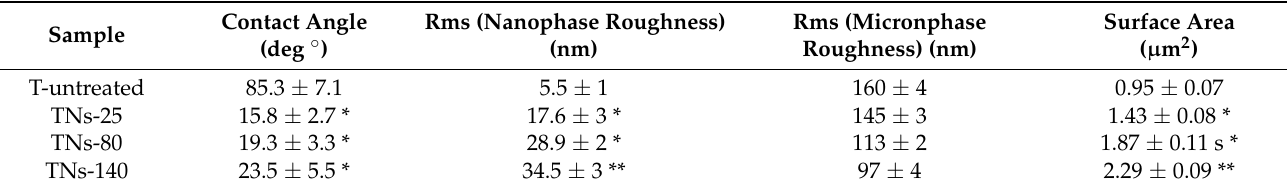
Table 3. Water contact angles, nanophase and micron-phase surface roughness values, and surface areas of T-untreated, TNs-25, TNs-80, and TNs-140 samples.